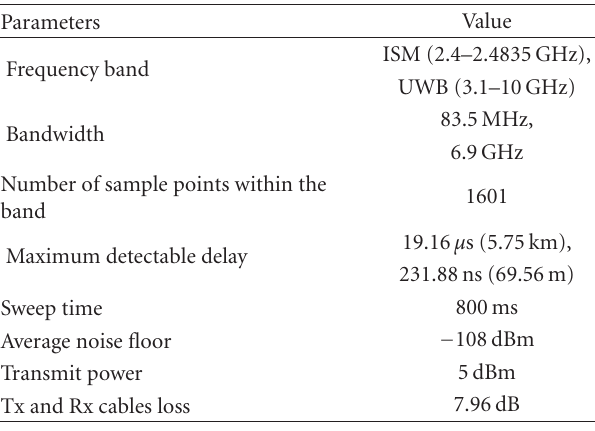
Table 1: Measurement system parameters.